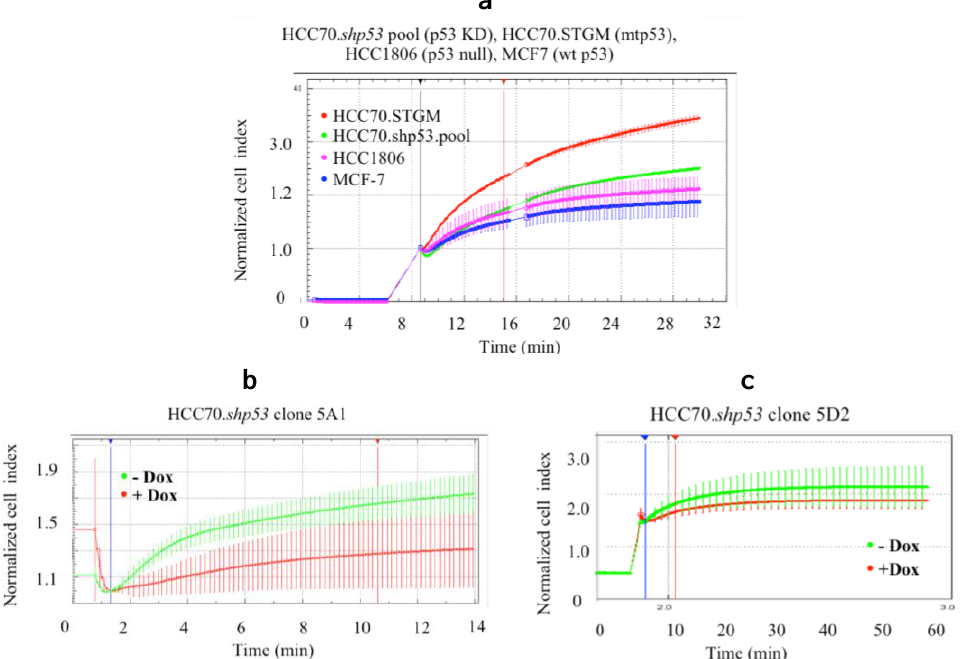
Figure 5. Cell deformability decreased upon mtp53 KD in pool population and in clonal cell lines with branched mesenchymal-like morphology. ( a ) Deformability (Normalized Cell Index) of HCC70 control cell line (red) or HCC70.shp53 pool (green), treated